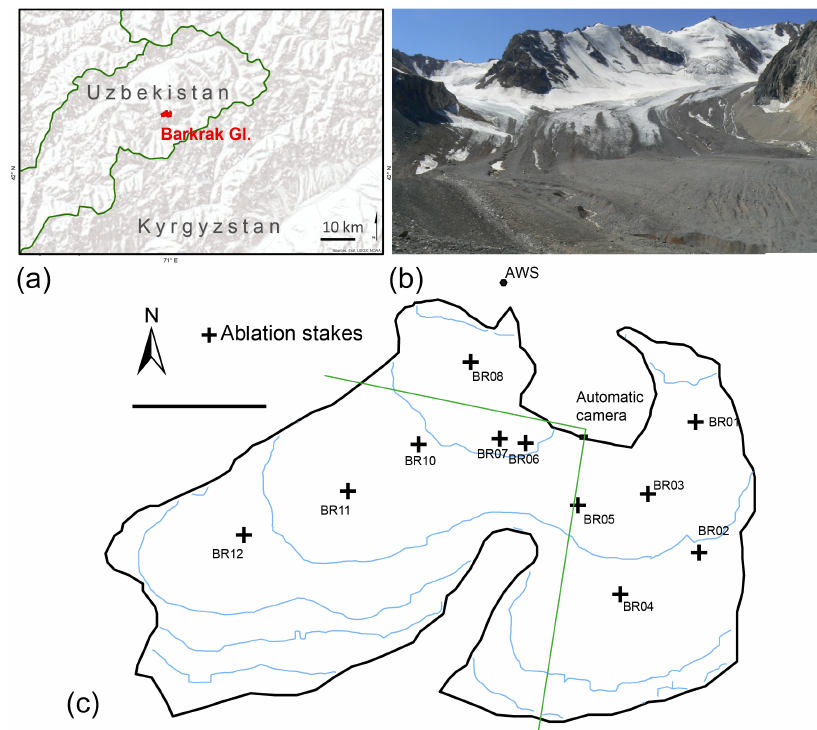
Figure 11. Mass balance network (c) on Barkrak Middle (Uzbekistan) with corresponding (overview) map (a) and picture (b) .